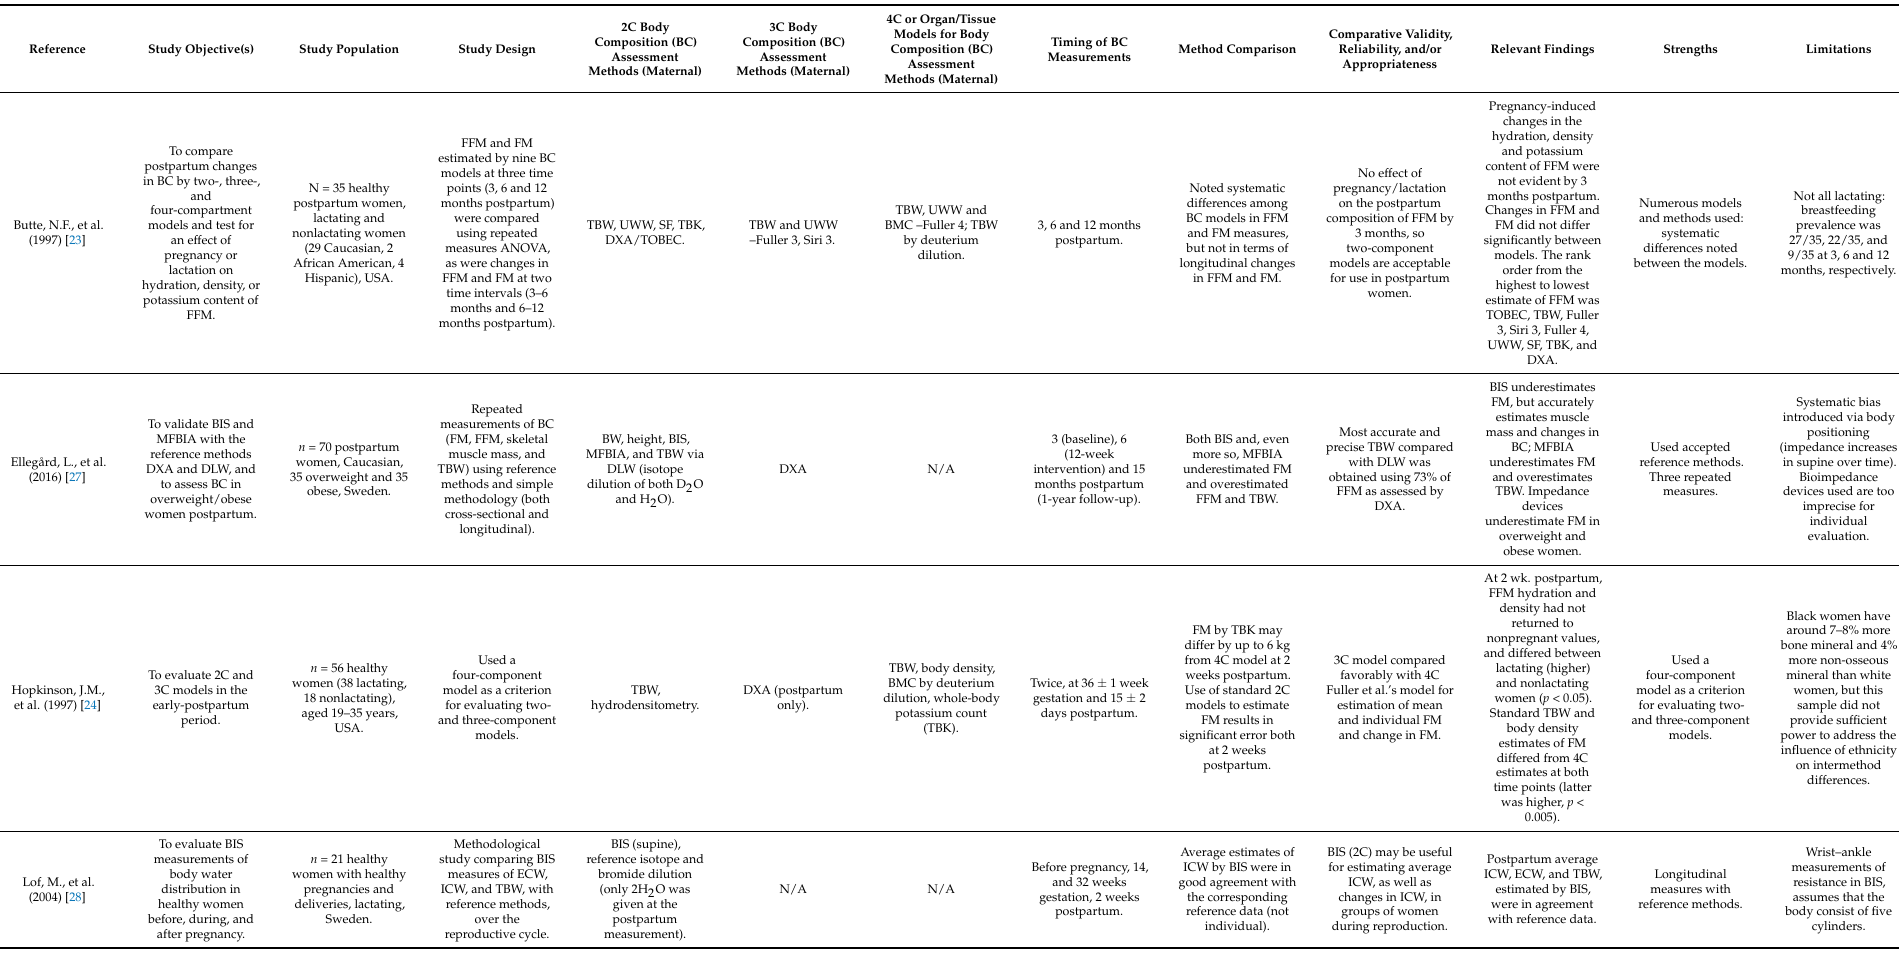
Table 2. Comparison studies assessing the validity of body composition assessment methods in lactating